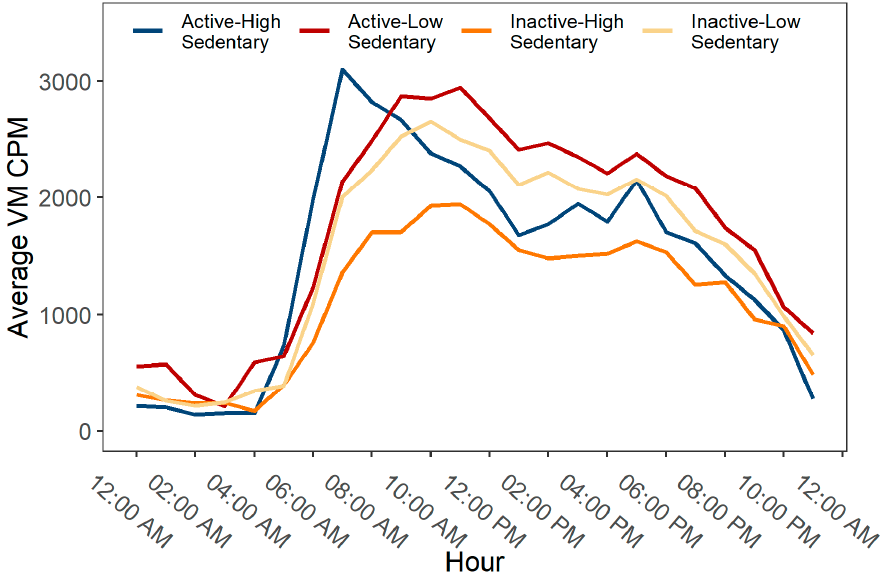
Figure 2. Hourly patterns of physical activity by mutually exclusive behavioral categories of physical activity (PA) and sedentary behavior (SB).